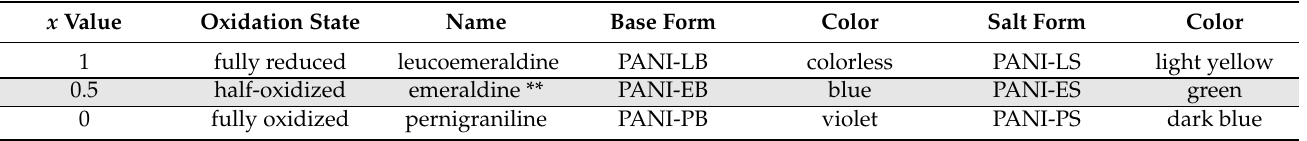
* Data obtained from [64–67]. ** The most stable emeraldine form of PANI is highlighted in grey for Table 3. PANI in various forms and oxidation states *.